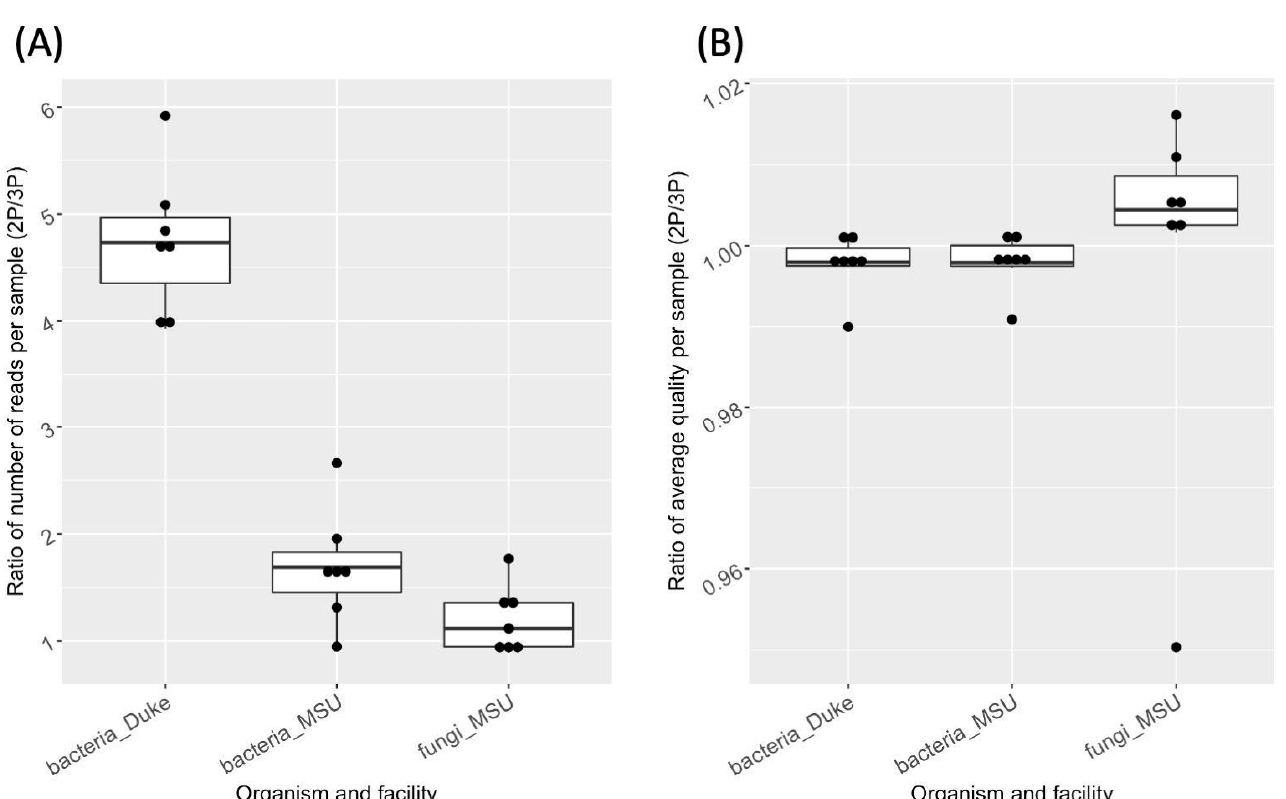
Figure 7. Comparison of the 2P and 3P sequencing results generated by independent sequencing facilities (datasets 2 and 4). ( A ) The ratios of two-step PCR (2P)-generated read numbers to those of three-step PCR (3P) per sample. ( B ) The ratios of 2P-generated average read quality to those of 3P per sample. bacteria_Duke = libraries targeting bacterial/archaeal communities and sequenced at Duke University, bacteria_MSU = libraries targeting bacterial/archaeal communities and sequenced at Michigan State University, and fungi_MSU = libraries targeting fungal community and sequenced at Michigan State University.